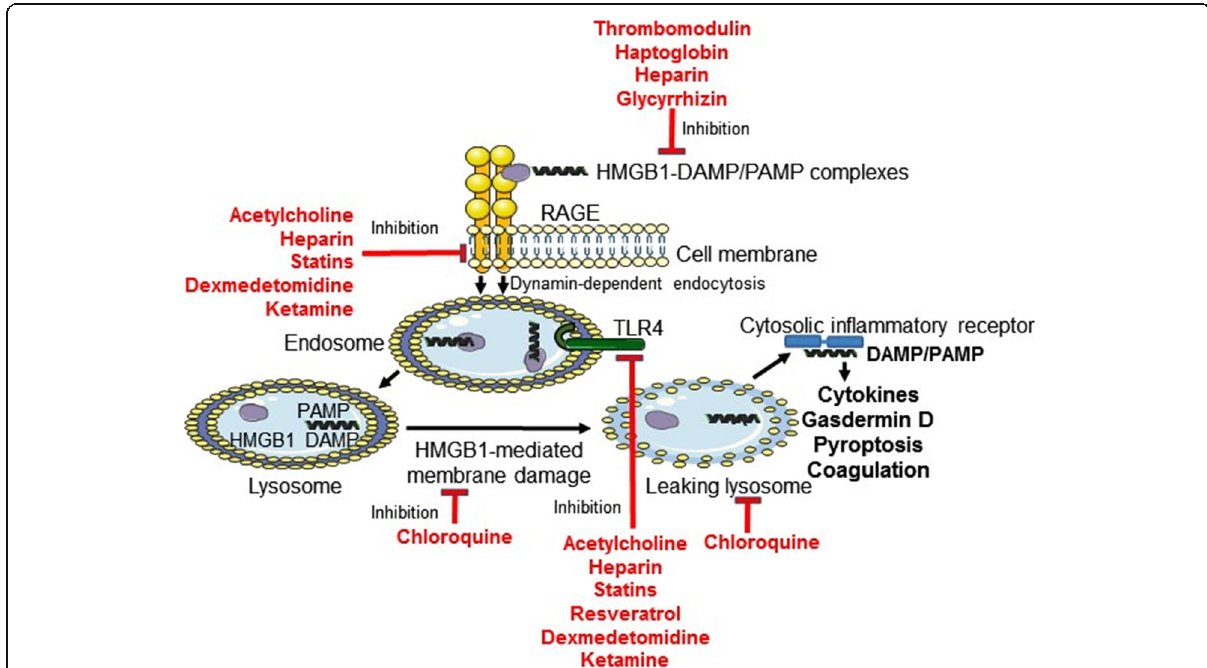
Fig. 2 Options to ameliorate HMGB1-mediated inflammation relevant for COVID-19 via pharmaceutical compounds approved for HMGB1- independent indications. The formation of proinflammatory HMGB1-partner molecule complexes is counteracted by thrombomodulin, heparin, haptoglobin, and glycyrrhizin. RAGE-HMGB1-mediated activities are inhibited by acetylcholine, heparin, statins, dexmedetomidine, and ketamine. TLR4-HMGB1 mediated activation is downregulated by acetylcholine, heparin, statins, resveratrol, dexmedetomidine, and ketamine. HMGB1- mediated disruption of lysosomal membrane is constrained by chloroquine phosphate and